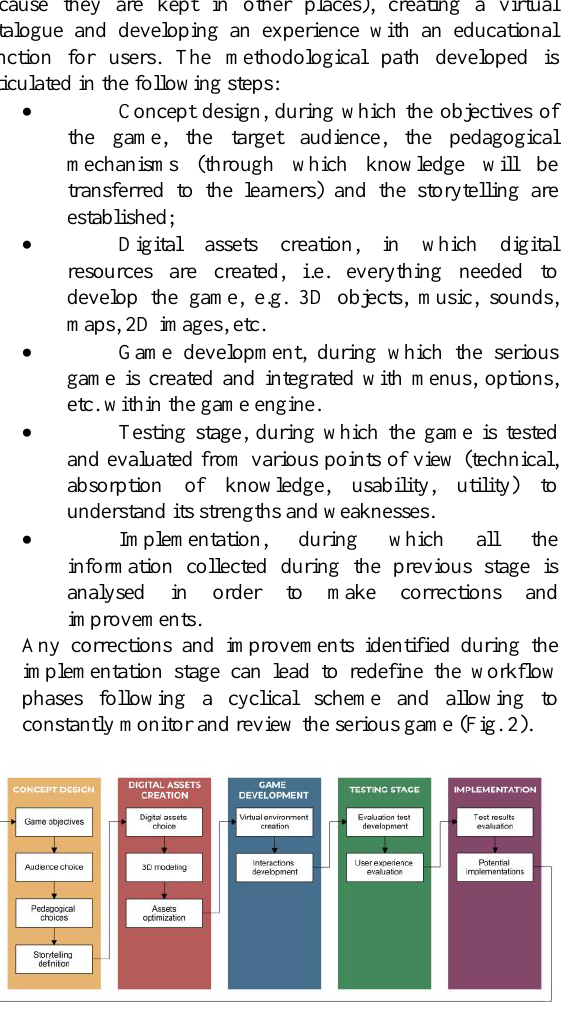
Figure 2. Adopted methodological workflow for the development of serious